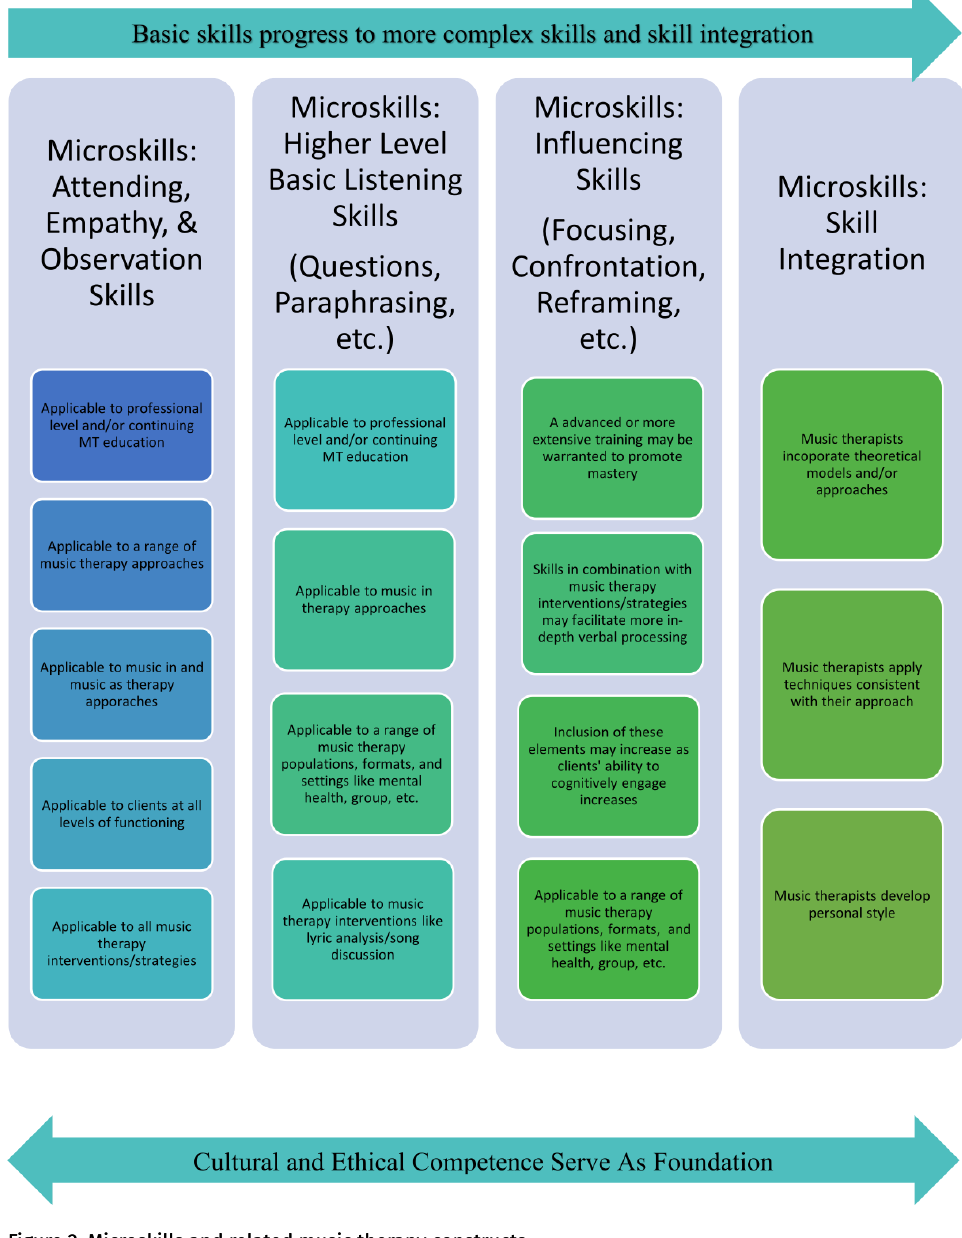
FFigigururee 2.2. MicrMicroskillsoskills andand rrelelatateded musicmusic thertherapapyy